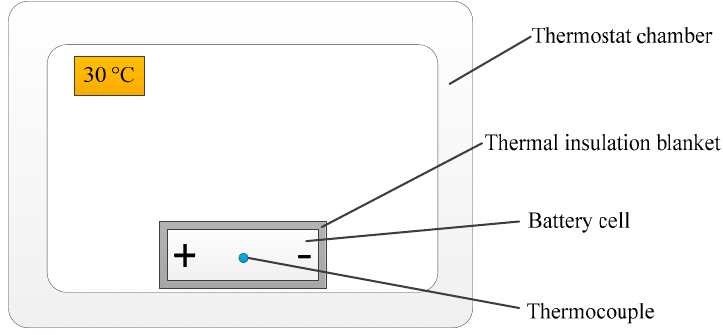
Figure 15. Experimental setup for measuring heat transfer coefficient ℎ .